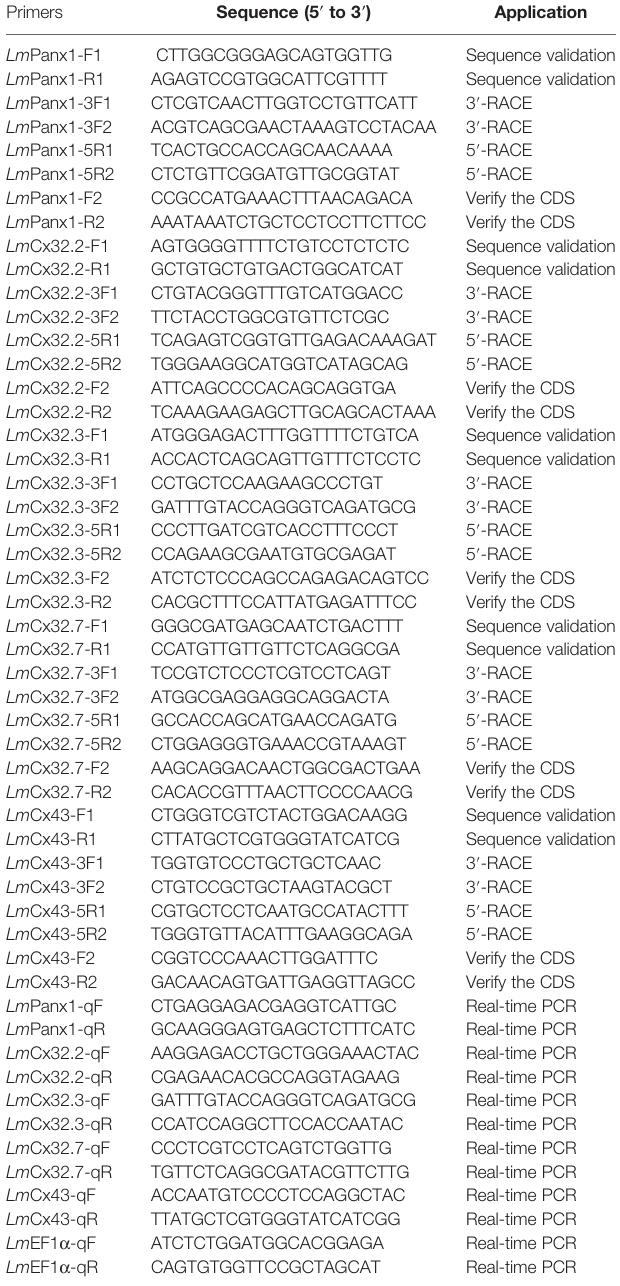
TABLE 1 | Primers used for cloning and real-time